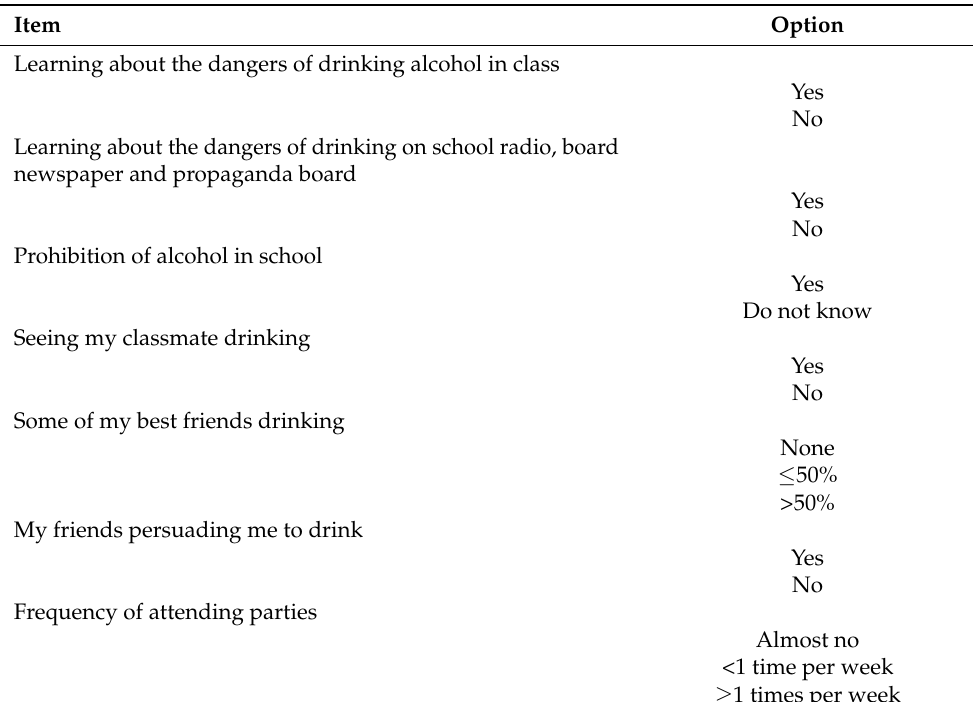
Table A1. Questionnaire of school environment related to alcohol